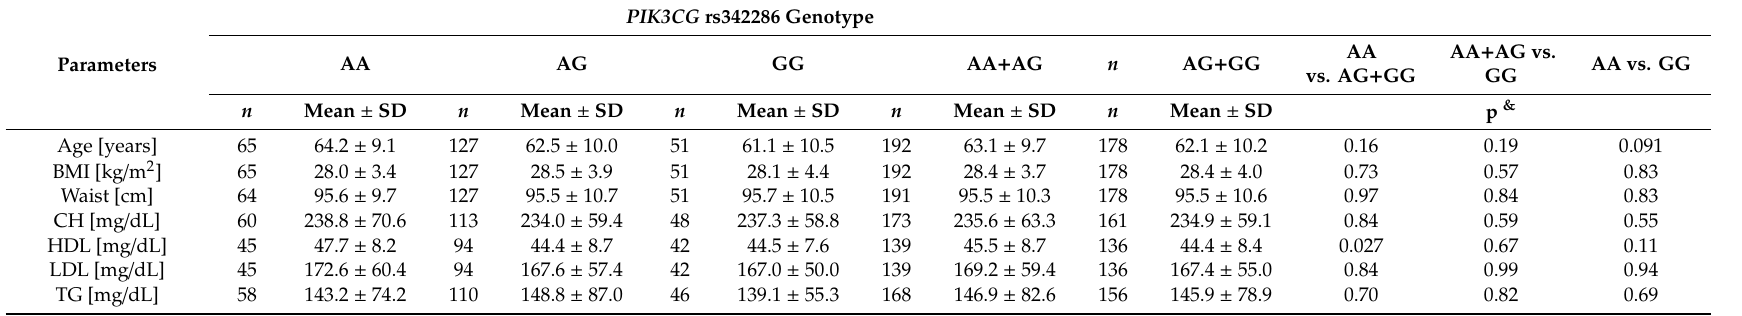
Table 6. Associations between the clinical parameters of patients with unstable angina and the PIK3CG genotypes.